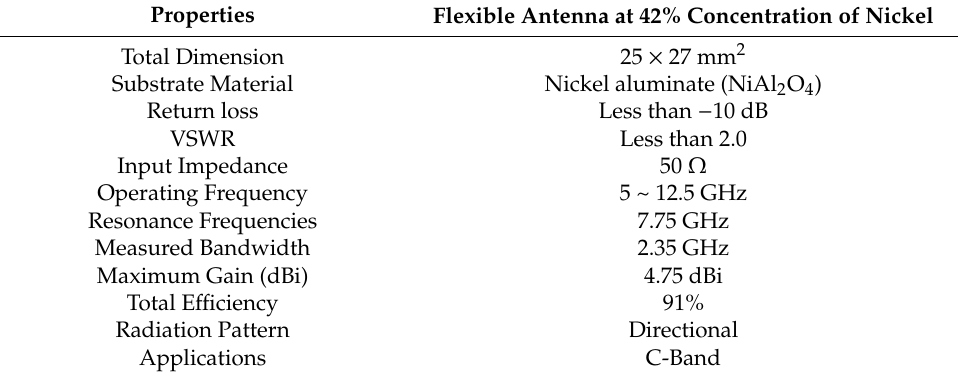
Table 4. Performance summary of the proposed flexible material-based patch